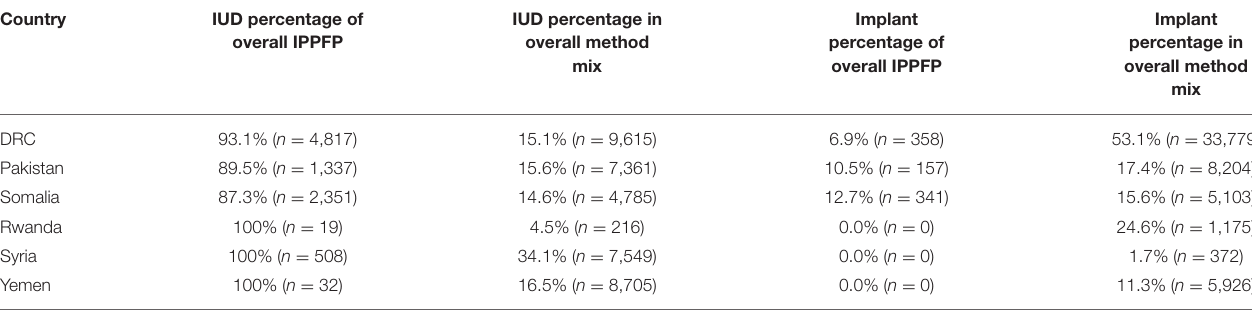
TABLE 4 | Percentage of IUD and implant as proportion of IPPFP and overall method mix.